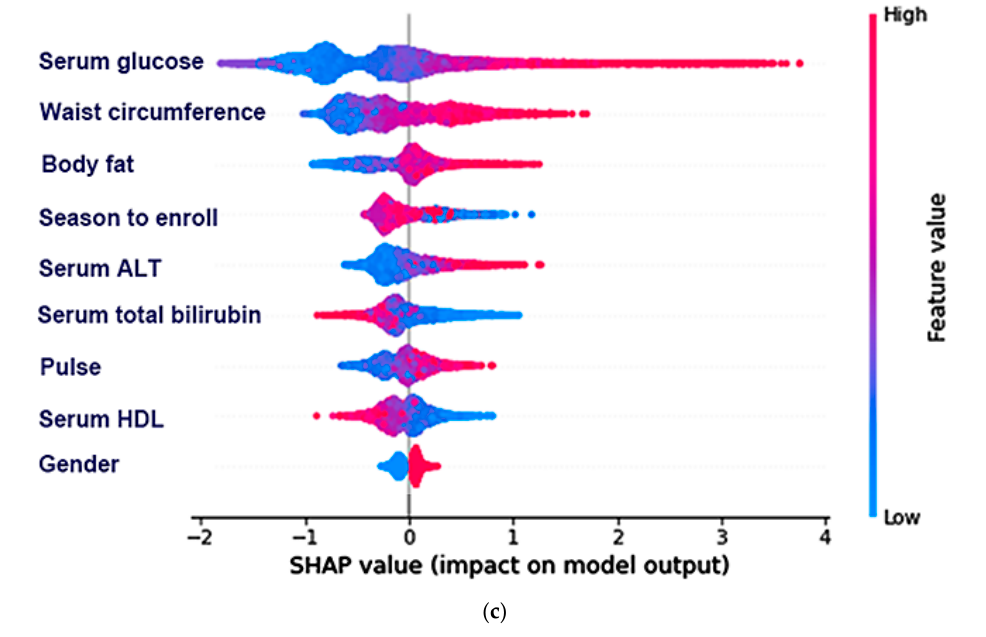
Figure 5. The relative importance of the top nine features for the insulin resistance (IR) prediction, as determined by the XGBoost and random forest algorithms. ( a ) IR prediction model with top 9 features using the XGBoost algorithm. ( b ) IR prediction model with top 9 features using the random forest algorithm. ( c ) Explanation of each feature impact on the IR prediction model by SHAP values using the XGBoost algorithm.